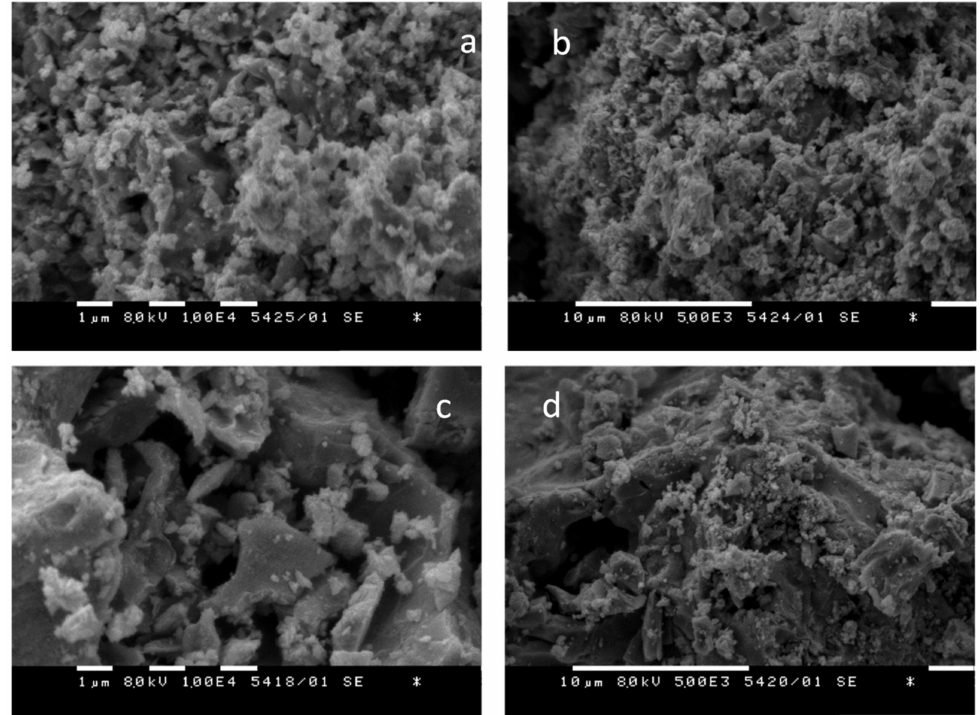
Figure 3. SEM images of MCF-S ( a , b ) and MCF-CA ( c , d